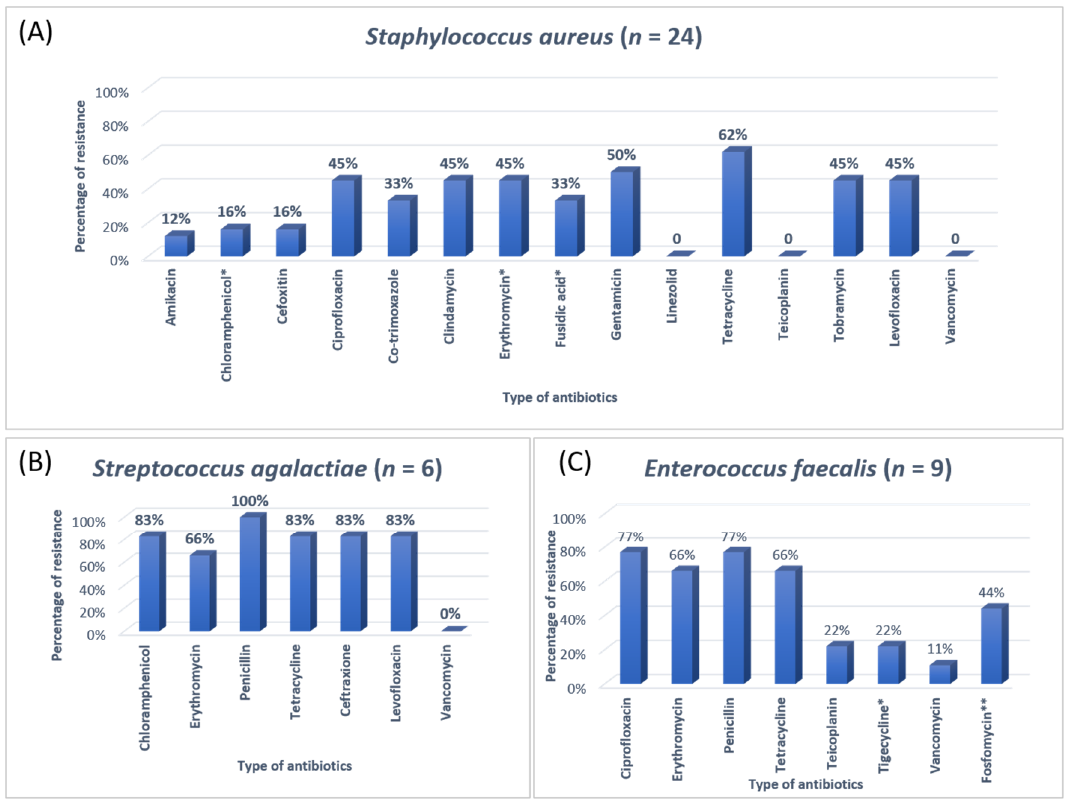
Table 2. The general prevalence of bacterial co-infections in COVID-19 patients admitted in ICU.